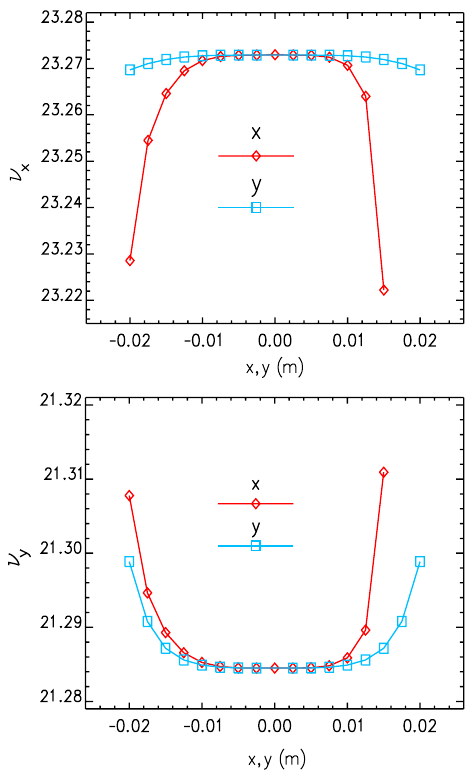
FIG. 16. (cid:8) x (top) and (cid:8) y (bottom) as functions of x and y after compensation of the 1st-order amplitude-dependent tune shifts.